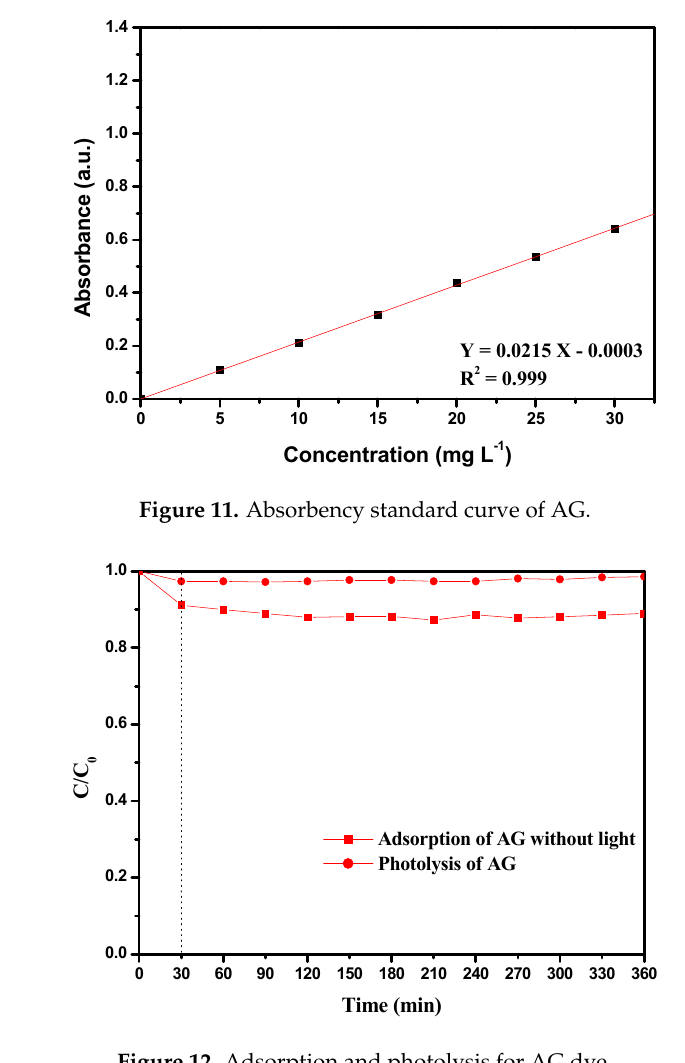
Figure 12. Adsorption and photolysis for AG dye.